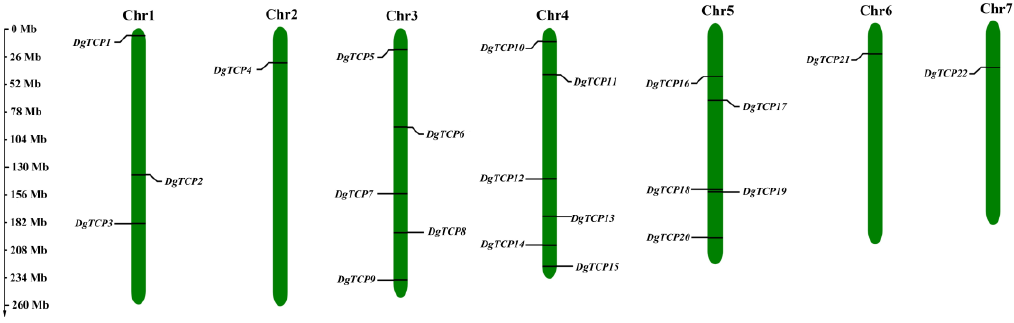
Figure 4. The chromosome locations of the DgTCP genes. The green bars represent Dglomerata chromosomes.